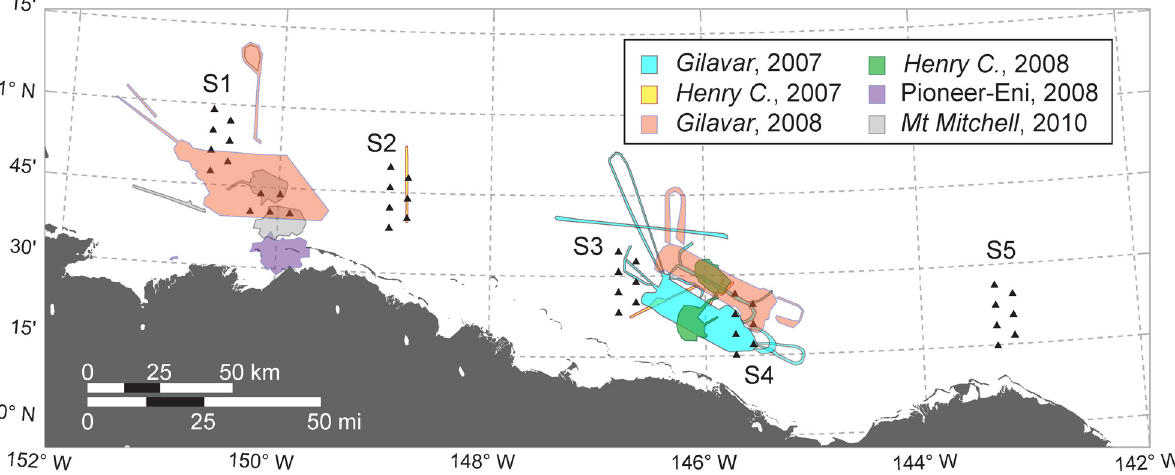
Fig 3. Locations of airgun use near the DASAR arrays in 2007, 2008, and 2010. Only operations that occurred either within the DASAR arrays or less than 50 km from the nearest DASAR are shown. (In 2009 there were no seismic exploration activities involving airguns in the area shown.) See Table 2 for dates of operation and array